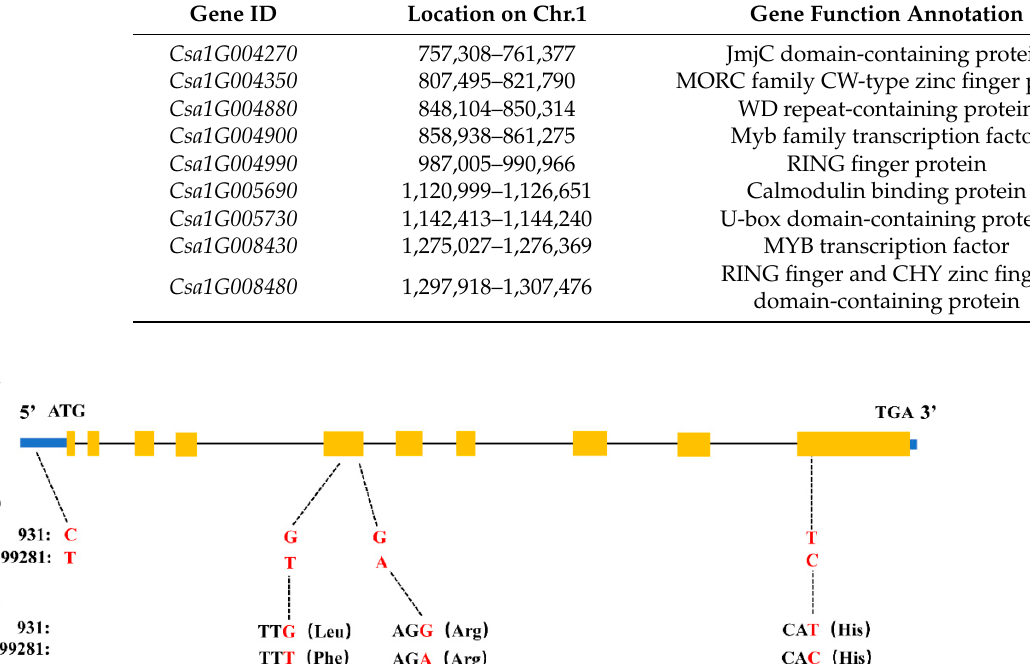
Table 3. Analysis of candidate genes related to cucumber heat tolerance.